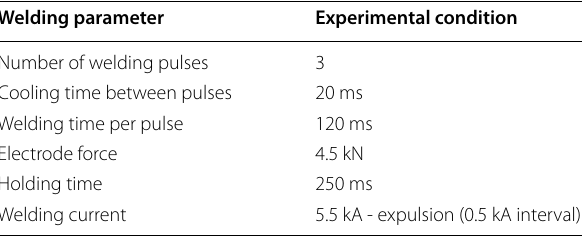
Table 2 Specific welding parameters used in the experiment Welding